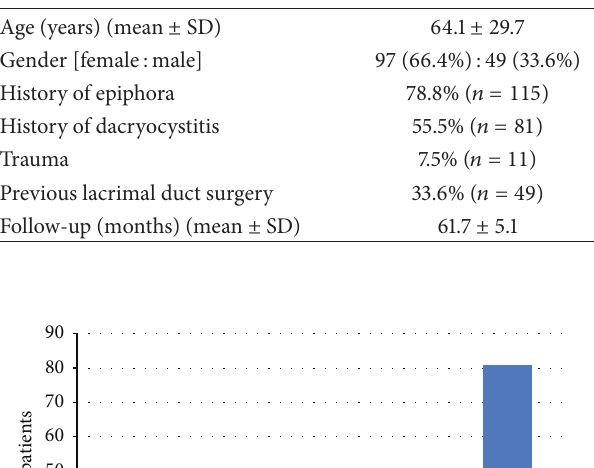
Table 1: Baseline characteristics of the study population.